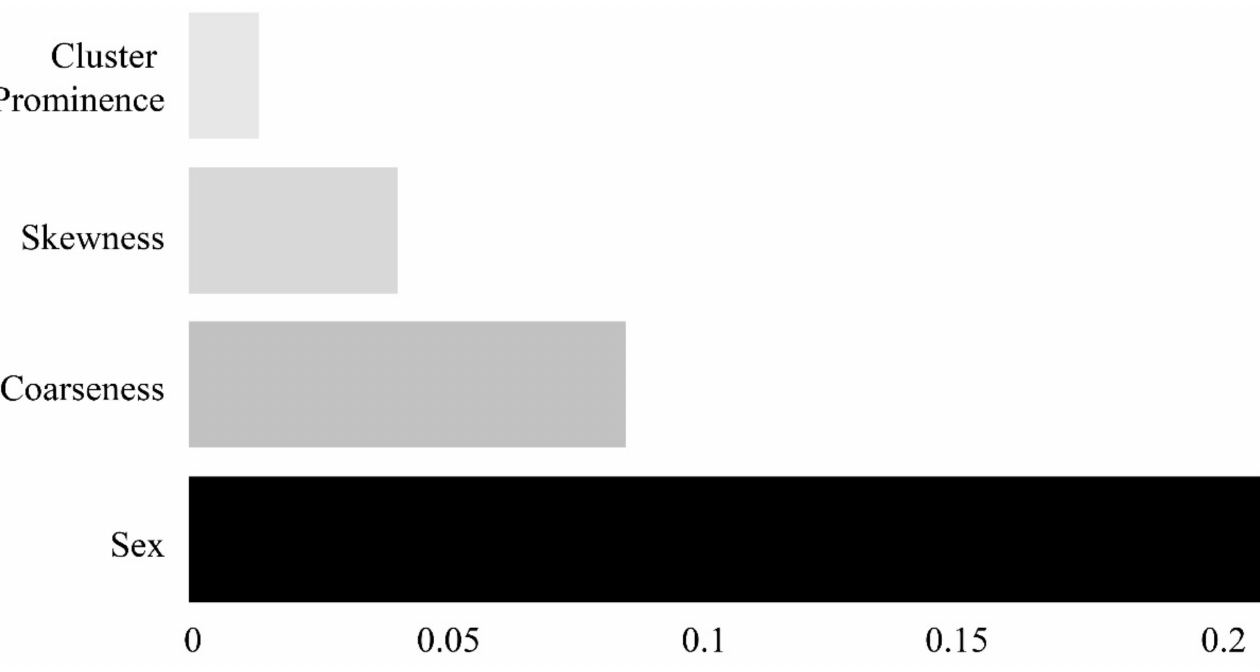
Figure 4. Feature importance plot showing the relative importance of four features with respect to the identification of sarcopenia and non-sarcopenia